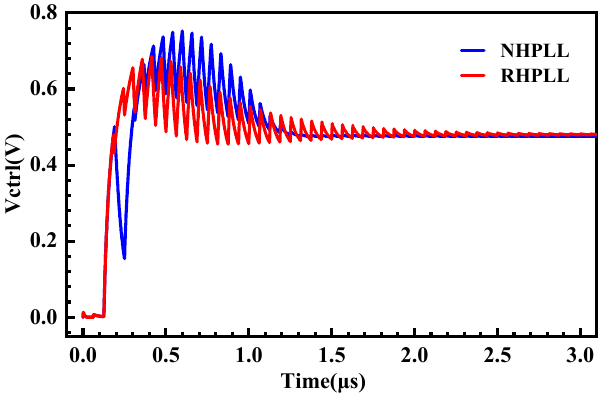
Figure 9. Locking processes of the RHPLL and NHPLL.